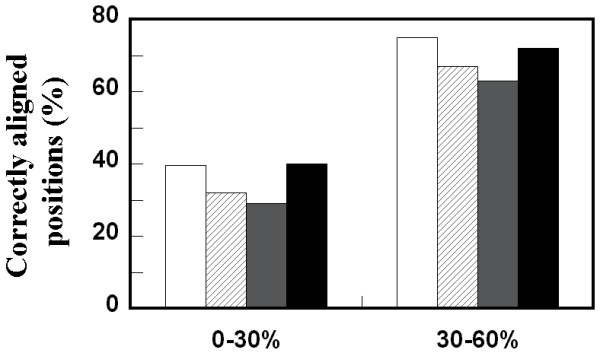
Comparison of sequence-structure alignments using several scoring functions. EvDTree, white bars; Gonnet, hatched bars; BLOSUM62, grey bars, and FUGUE, black bars. Gap opening and gap extension penalties have been separately optimized for each scoring function.